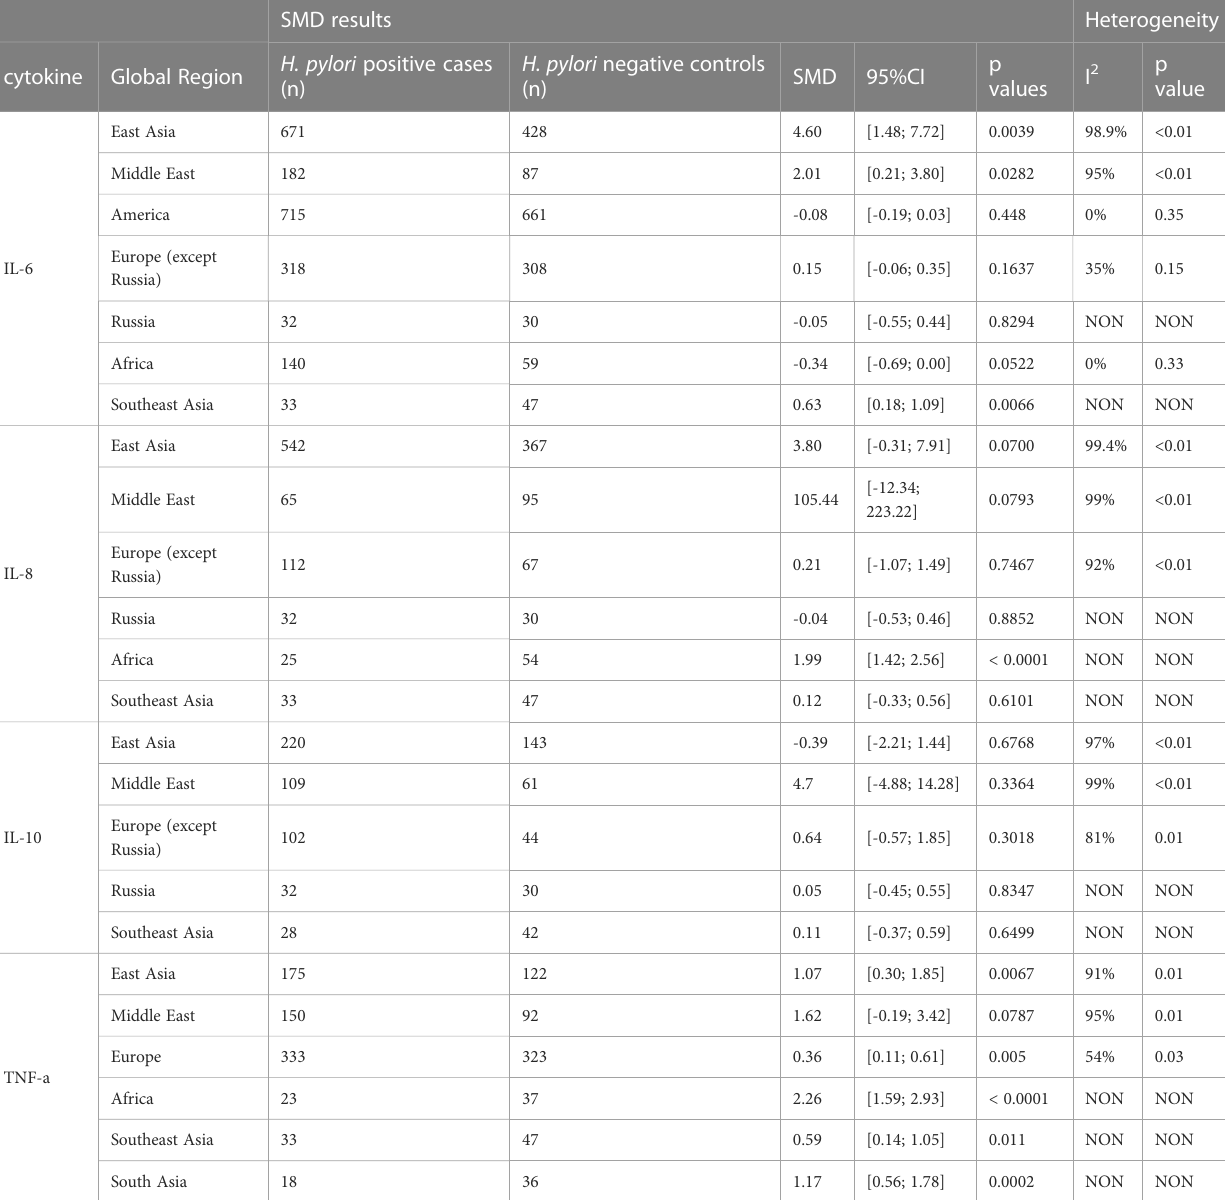
TABLE 2 Standardized mean differences of serum level of IL-6, IL-8, IL-10 and TNF-a upon H. pylori infection in different global regions. SMD